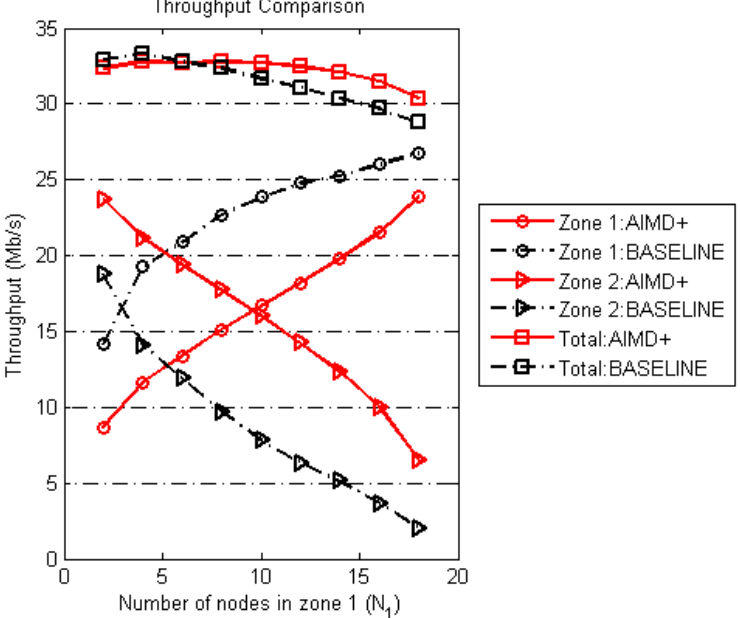
Figure 13. Throughput comparison of AIMD+ with